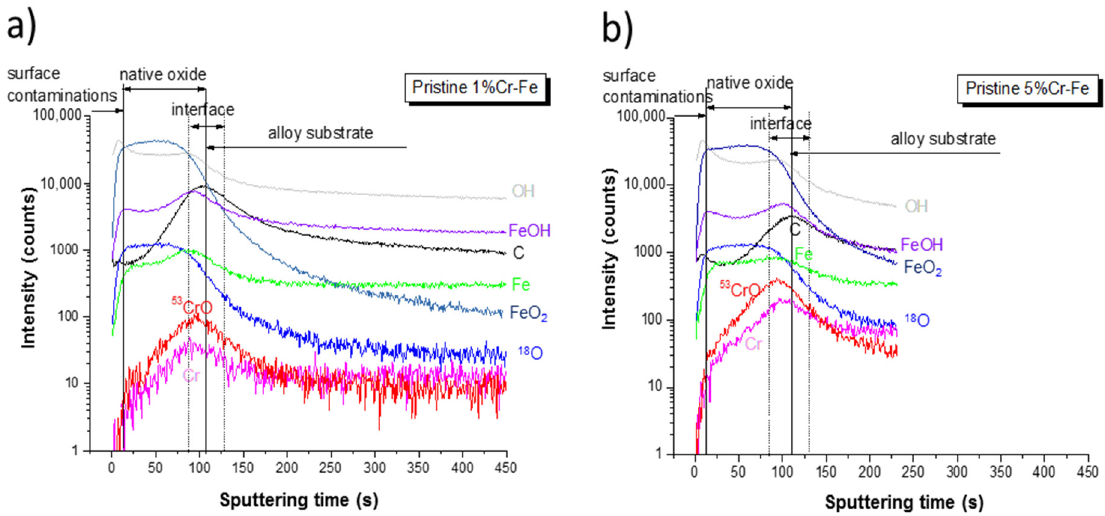
Electrochem 2021 , 2 , FOR PEER REVIEW Figure 10. ToF-SIMS negative ion depth profiles for the ( a ) Fe-1% Cr and ( b ) Fe-5% Cr pristine samples.